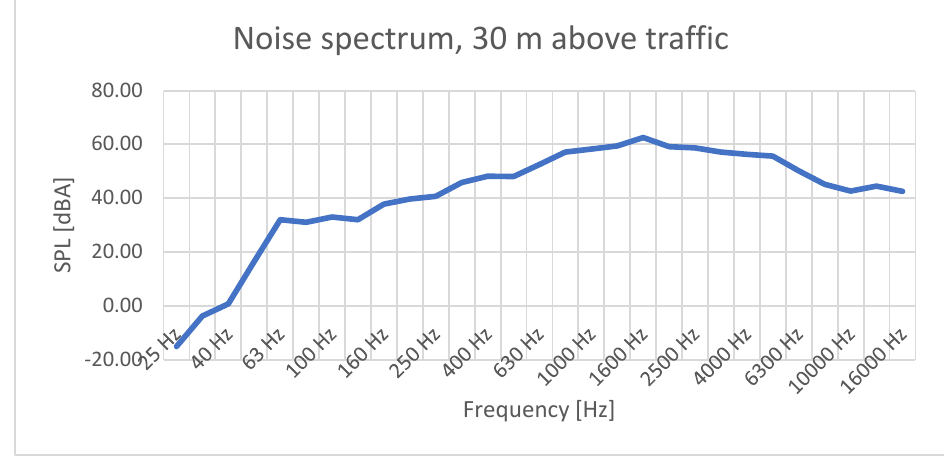
Figure 6. SPL recorded for higher frequency range, ground level (at 8 kHz, 10 kHz and 12.5 kHz, with blue—8 kHz, orange—10 kHz, and grey—12.5 kHz components).